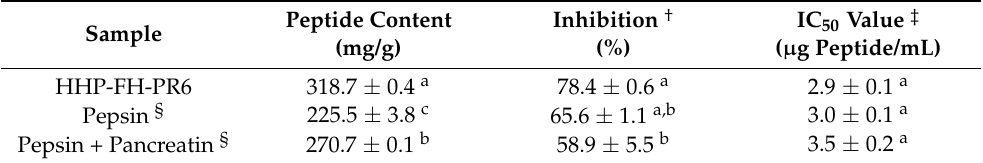
Table 3. Effect of digestion by gastrointestinal proteases on peptide content and HMG-CoA reductase inhibitory activity of HHP-FH-PR6 *.